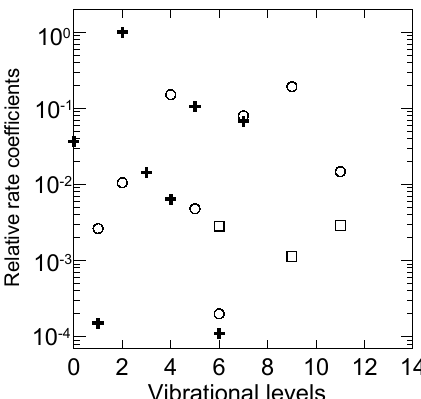
Fig. 5. Calculated relative rate coefficients for the process (11) for Figure 5. Calculated relative rate coefficients for the reaction (11) for vibrational level v=0 of (X 2 5 g ) ion with O 2 (X 3 6 g ,v ), vibrational level v =0 of the O + the O 2+ (X 2 Π g ) ion with O 2 (X 3 Σ g– ,v), O 2 (a 1 ∆ g ,v), O 2 (b 1 Σ g+ ,v) productions – squares, circles and 2 crosses, respectively. O 2 (a 1 1 g ,v) , O 2 (b 1 6 + g ,v ) productions – squares, circles and crosses, respectively.